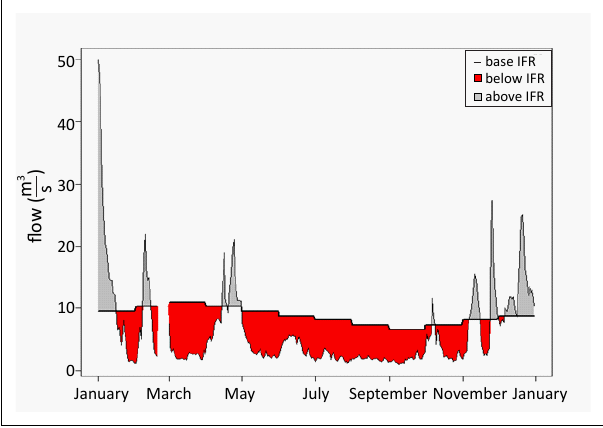
FIGURE 4: River flow analyses for the Letaba River for the period 01 January 2007 – 31 December 2007, where the minimum in-stream flow requirement (IFR) is determined for all the main rivers in the Kruger National Park, providing a threshold against which to examine daily flow rates. The IFR is measured in m 3